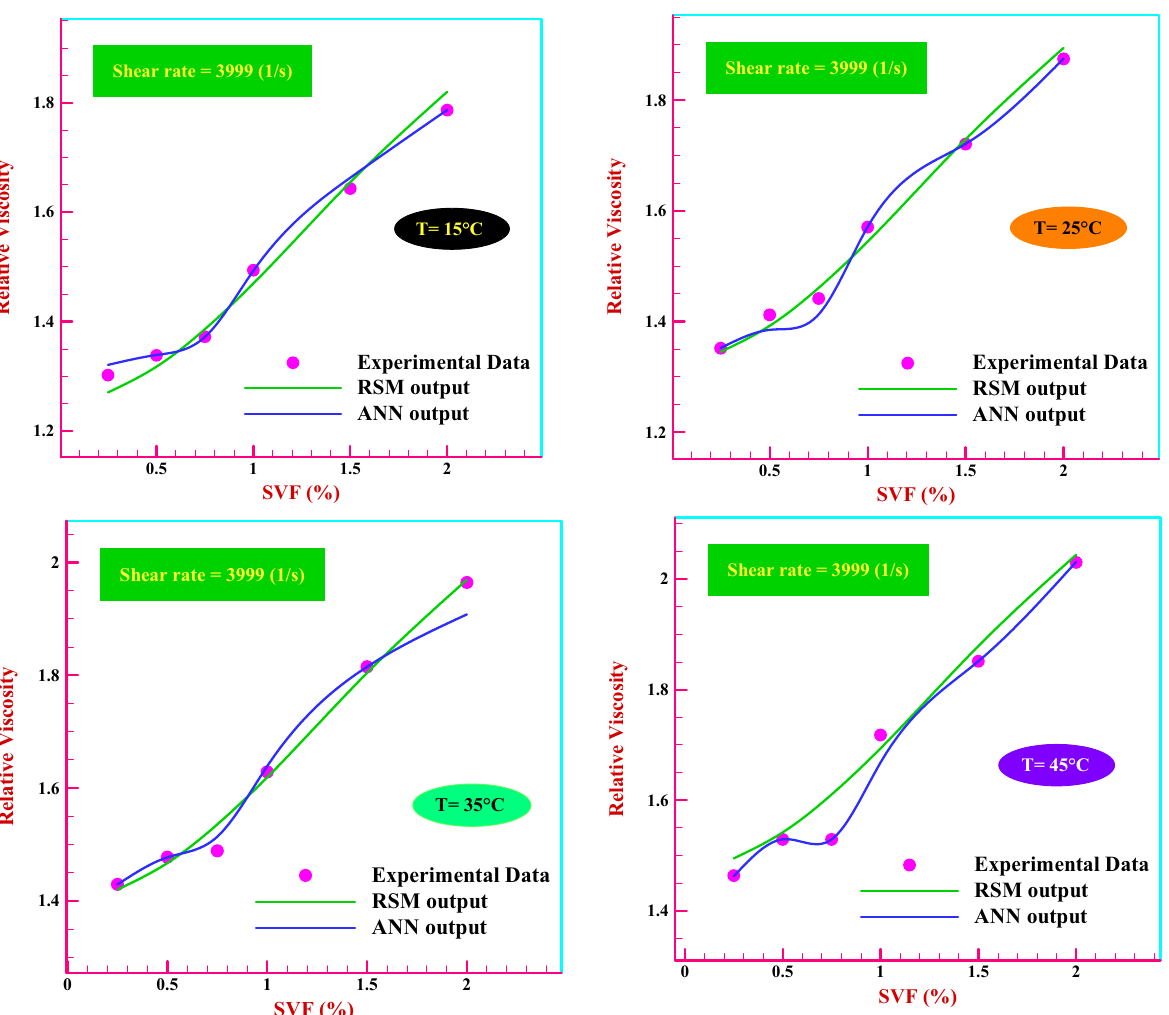
Figure 10. Comparison between empirical data and modeling outputs of ANN and